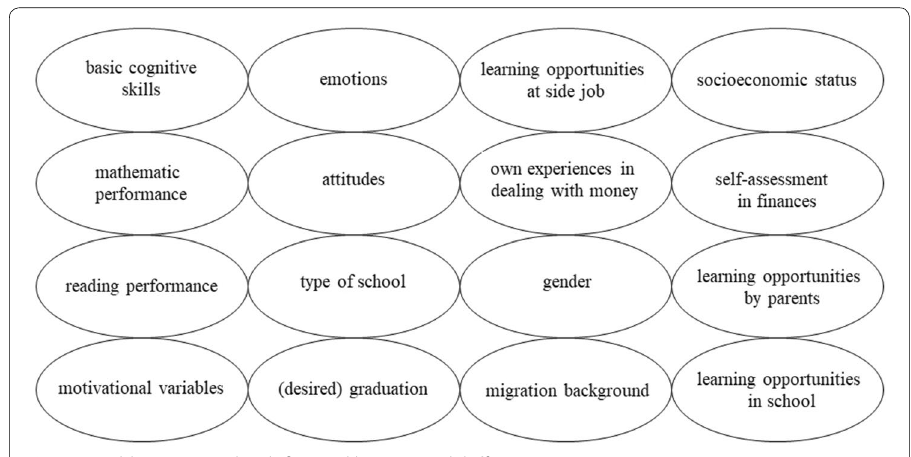
Fig. 1 Variables associated with financial literacy (Rudeloff